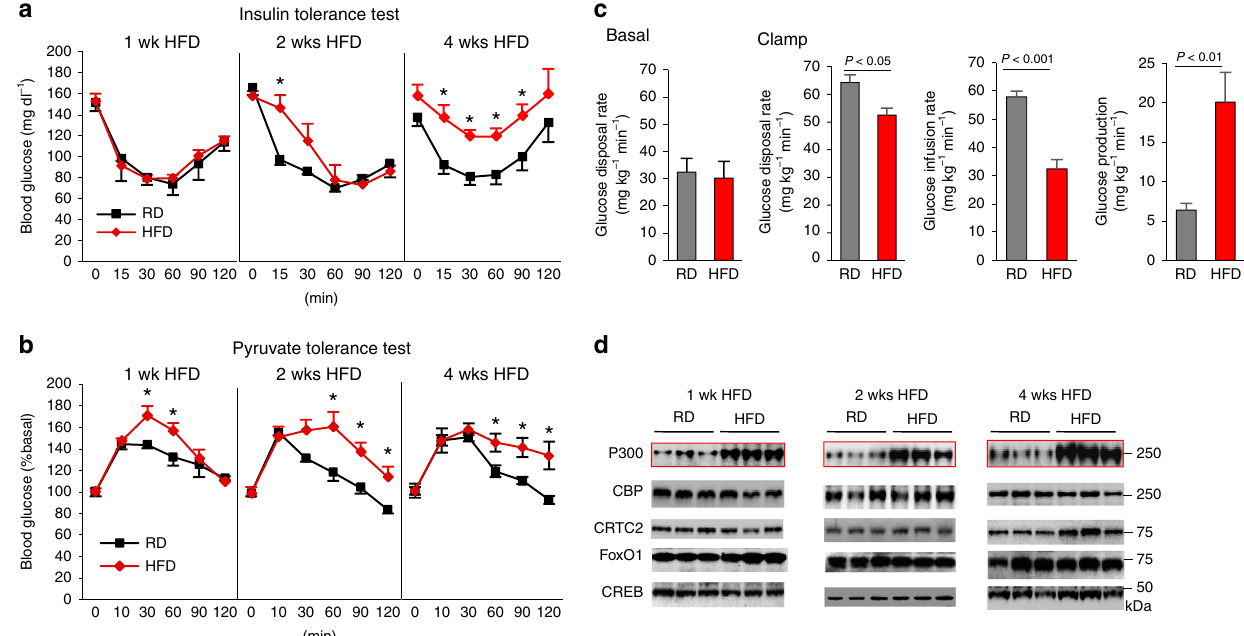
Fig. 1 HFD feeding results in P300 induction in the liver. a , b Insulin tolerance test (4 h fasting, 0.8 unit per kg, n = 4) a and pyruvate tolerance test (5 h fasted, 2 g kg − 1 , n = 4) b in C57BL/6 mice fed a regular diet or HFD for 1 – 4 weeks. c WT mice were fed a regular diet or an HFD for 2 weeks. Basal glucose production in mice after 5 h fasting ( left ) and glucose disposal rates, glucose infusion rates, and hepatic glucose production during the clamp experiment ( n = 4 – 5). d Liver tissues were harvested in mice after feeding on an HFD for 1, 2 and 4 weeks, each lane represents a mouse sample. Data are presented as mean ± s.e.m. Statistical signi fi cance was calculated with a Student ’ s t